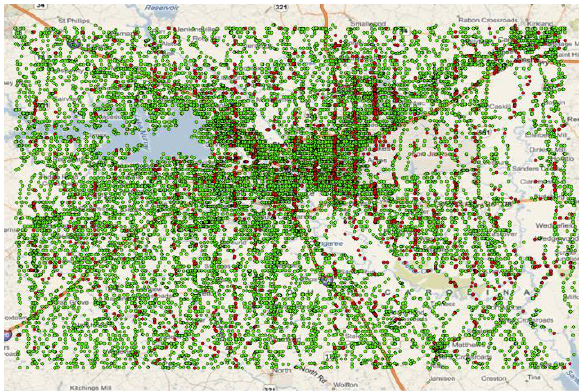
Figure 14: Automated shear analysis along seam lines. 2134 locations (red) out of over 30,000 (green) have questionable